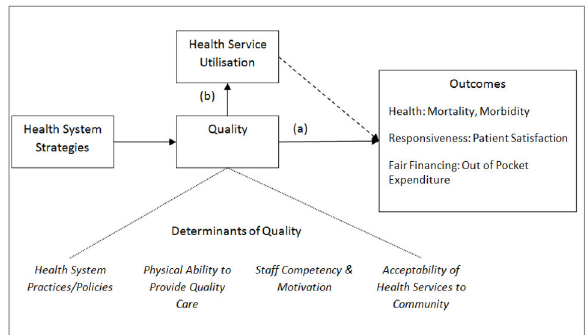
Figure 1. Conceptual Framework of Pathways between Strategies, Quality and Outcomes. presumed direct relationships while indirect relationships are represented by dashed lines. Broad determinants of quality that may be targeted by strategies are shown at the bottom of the figure. Health system strategies lead to improved quality which can either (a) directly lead to improved outcomes or (b) lead to improved health service utilisation which may indirectly lead to improvements in outcomes. An example of pathway (a) may be a maternal death audit, targeting the competency of staff, resulting in higher use of correct management techniques leading to lower mortality. An example of pathway (b) might be renovation of primary care facilities leading to higher community acceptability, resulting in more children being brought for treatment and thus a reduction in deaths due to treatable